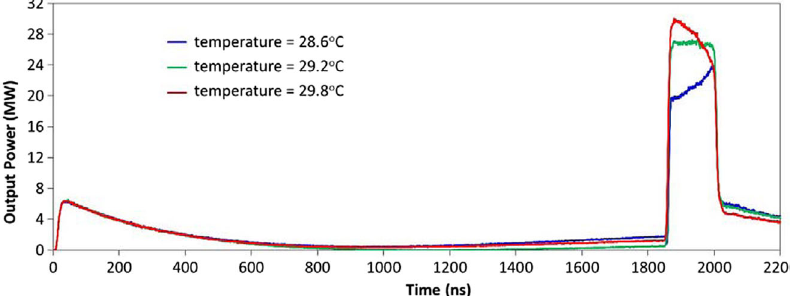
FIG. 12. Measured pulse shape at XBOX-3 when pulse compressor cavities are detuned by heating above or below the temperature from perfect tune.